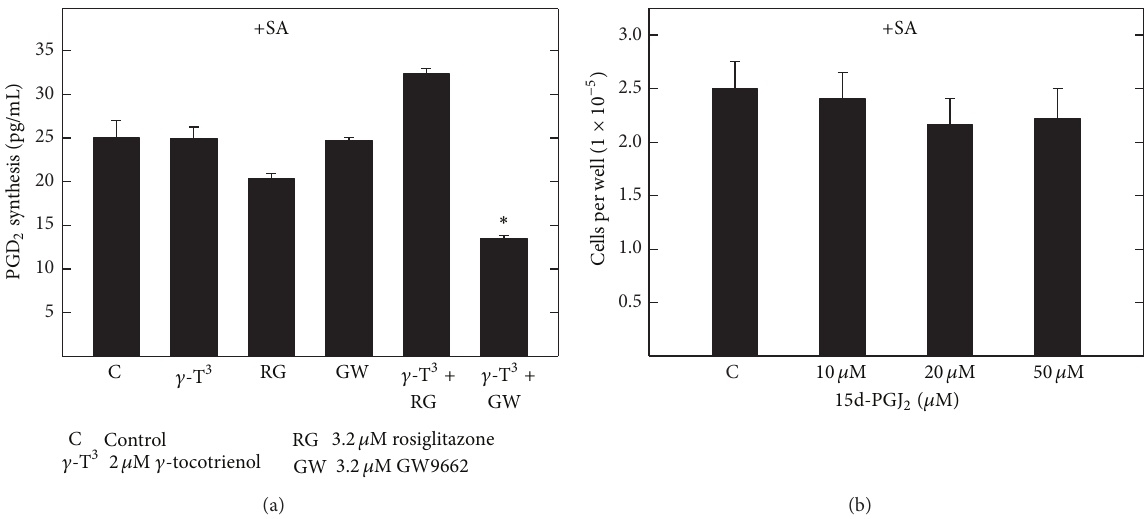
Figure 6: (a) Effect of 𝛾 -tocotrienol, rosiglitazone, and GW9662 given alone or in combination on PGD 2 synthesis and (b) treatment effect of 15d-PGJ 2 in +SA cells. +SA cells were plated at 1 × 1 0 6 cells/100 mm culture dish and treated with control or treatment media for 4-day incubation period. Afterwards, whole cell lysates were assayed for PGD 2 according to the manufacturer’s protocol. Vertical bars indicate the amount of PGD 2 synthesized (pg/mL) ± SEM in each treatment group. To study effect of 15d-PGJ 2 , +SA cells were plated at a density of 5 × 1 0 4 (6 wells per group) in 24-well culture plates and exposed to treatment media for a 4-day period. Afterwards viable cell number was determined using MTT colorimetric assay. Vertical bars indicate mean cell count ± SEM in each treatment group. ∗ 𝑃 < 0.05 as compared with vehicle-treated controls.